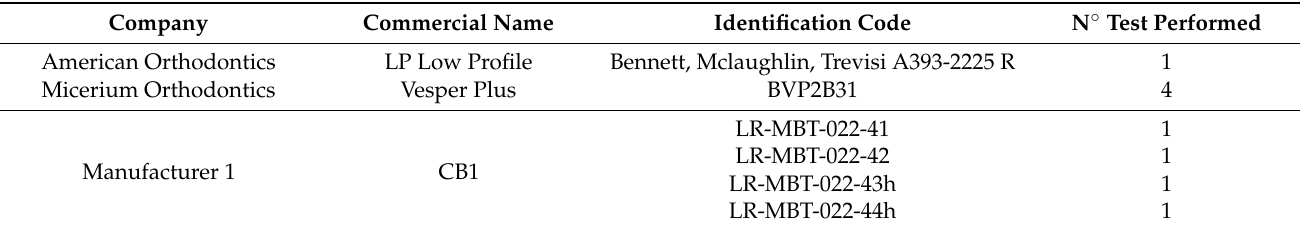
Table 3. Conventional brackets tested.